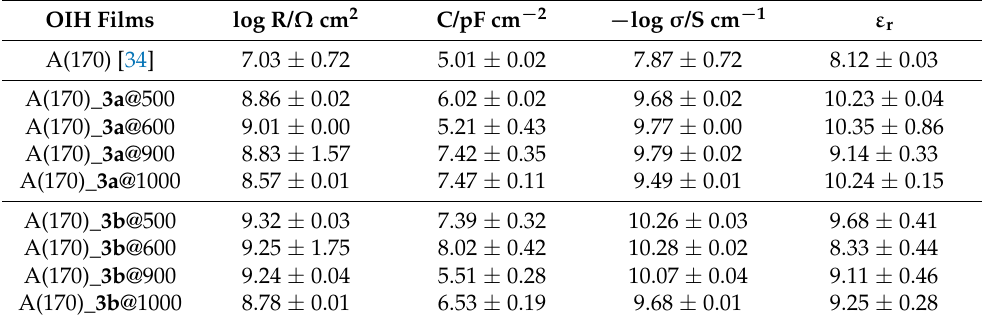
Table 2. Electrical properties of the OIH samples based on A(170) matrices doped with different imidazole derivative